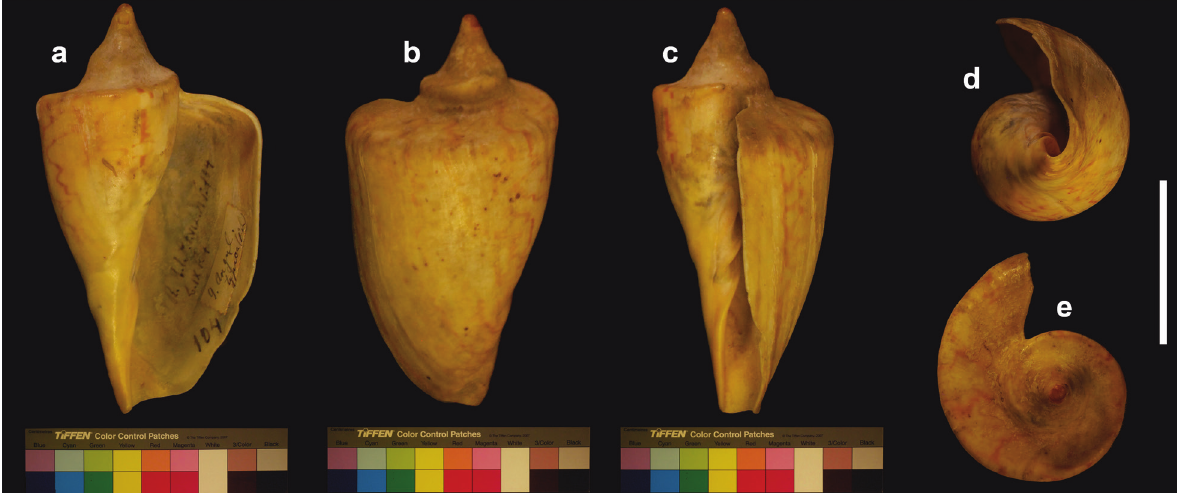
Figure 14. Voluta angulata typica , specimen figured by Lahille (1895: pl. VI, fig. 104; pl. IX, fig. 4) a Apertural view b Dorsal view c Lateral view d Umbilical view e Apical view. Scale bar: 5 cm.